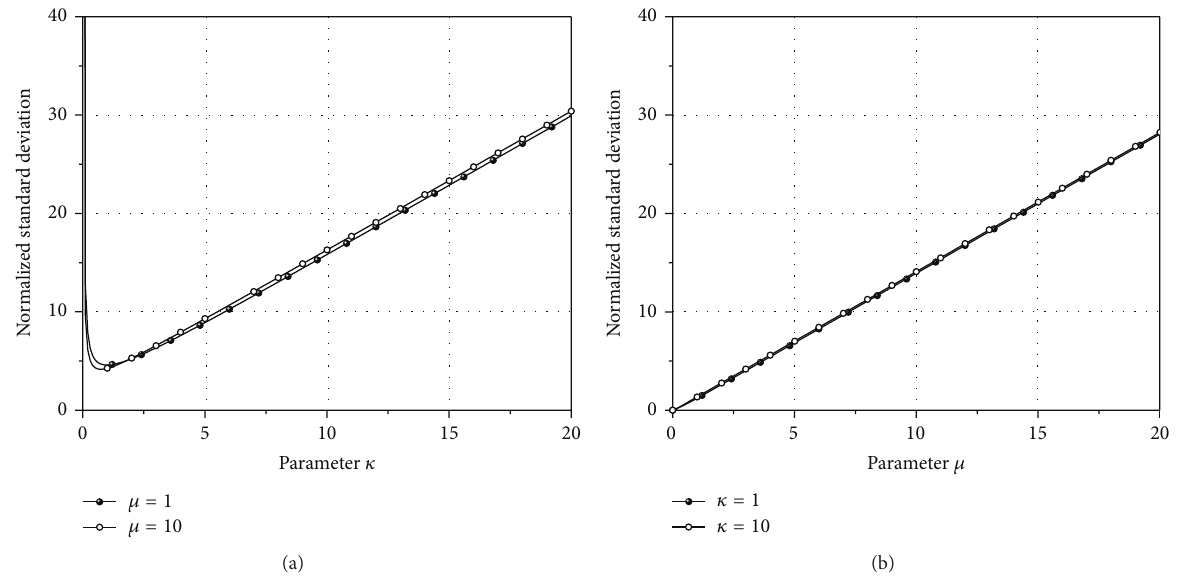
]| 𝜅 and for 𝜇 = {1, 10} . (b) 𝑛=1 as function of ML